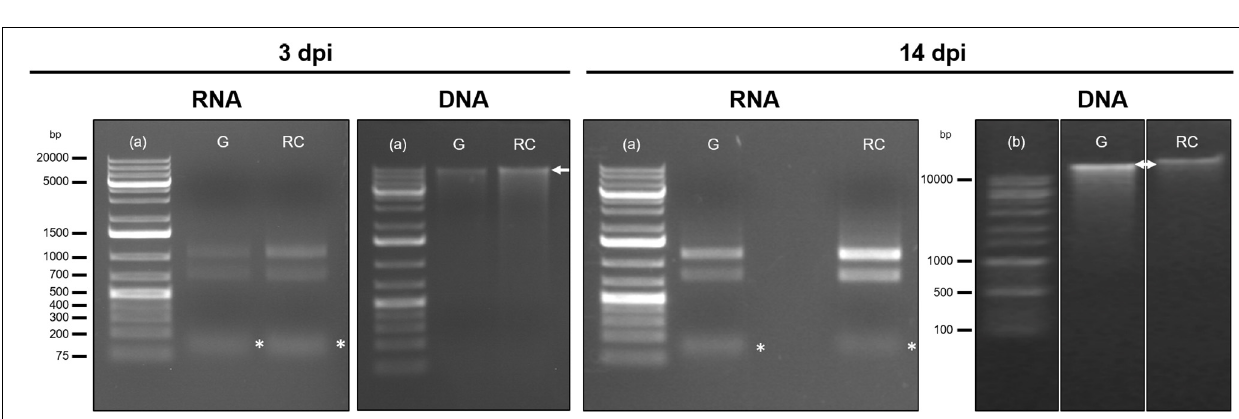
FIGURE 3 | Integrity assessment by gel electrophoresis of total RNA and genomic DNA extracted from galls at 3 days post infection (dpi) and 14 dpi and uninfected control root samples. From the left to the right: samples loaded were RNA and DNA from galls (G) and control roots (RC) samples either at 3 dpi or at 14 dpi, as indicated. A high molecular weight genomic DNA band ( > 10000 bp) is indicated by a white arrow. Two ribosomal bands are distinguished in the RNA samples and a low molecular weight band, corresponding to the small RNAs represented by an asterisk below the 200 bp marker band ( ∗ ). 1% Agarose gels were stained with 6% ethidium bromide; run at 70 V for 40 min for DNA and 30 min for RNA. The gel of DNA samples at 14 dpi was run at 100 V for 30 min. (a) Thermo Scientific TM GeneRuler TM 1 kb Plus DNA Ladder; (b) 1 kb ( + ) DNA Ladder; bp, base